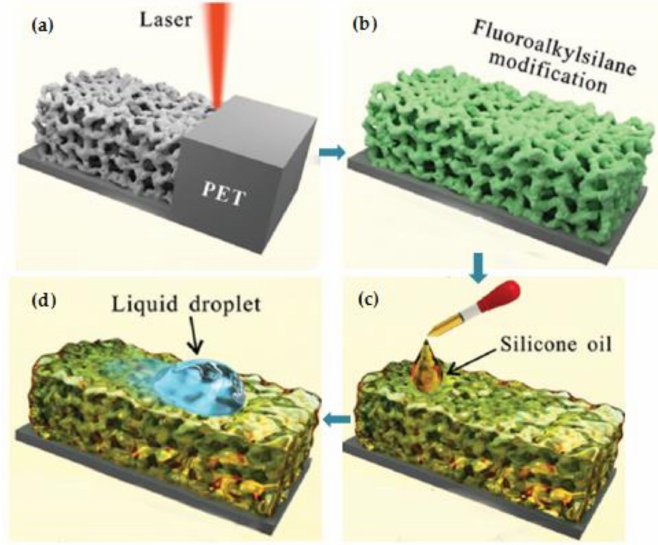
Figure 22. Schematic diagram of the preparation steps of slippery micro-network on PET